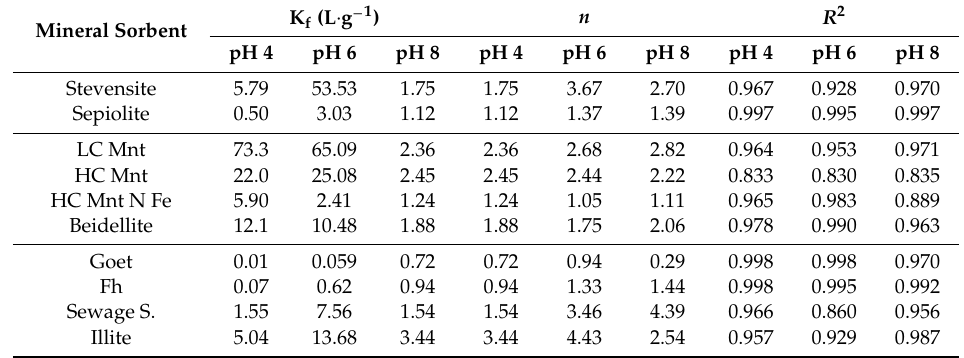
Table 3. Freundlich isotherm fitting parameters.